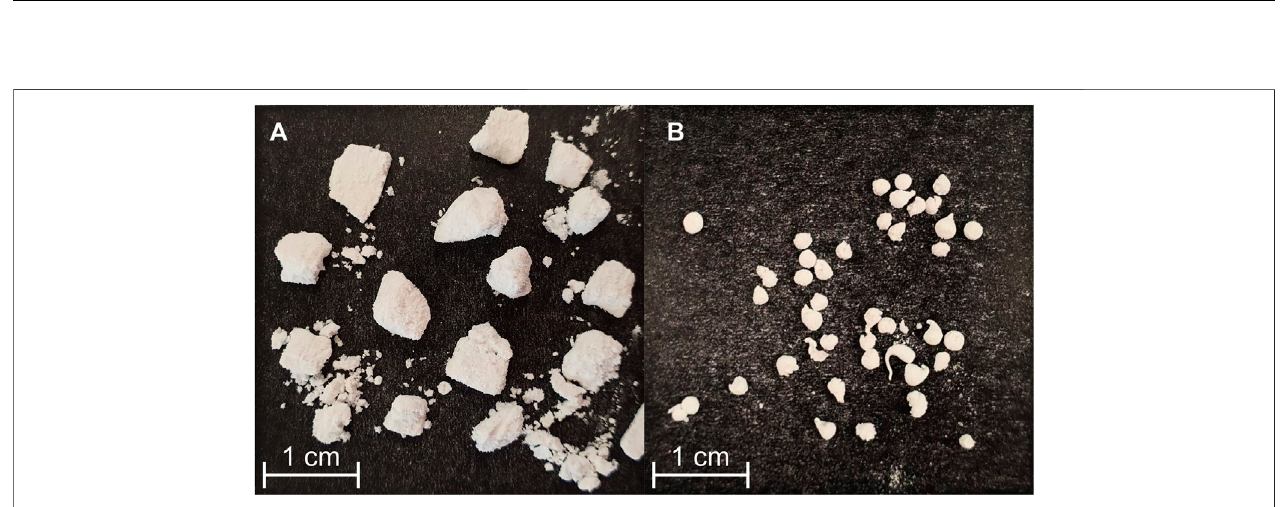
FIGURE1| Left :Schematiccross-sectionoftheTESsystem,comprisingalayeredthermochemicalheatstorage(TCS)unitontopofasensibleheatstorage(SHS) unit. Right : Schematic cross-section of a single reactor tube of the TCS unit.